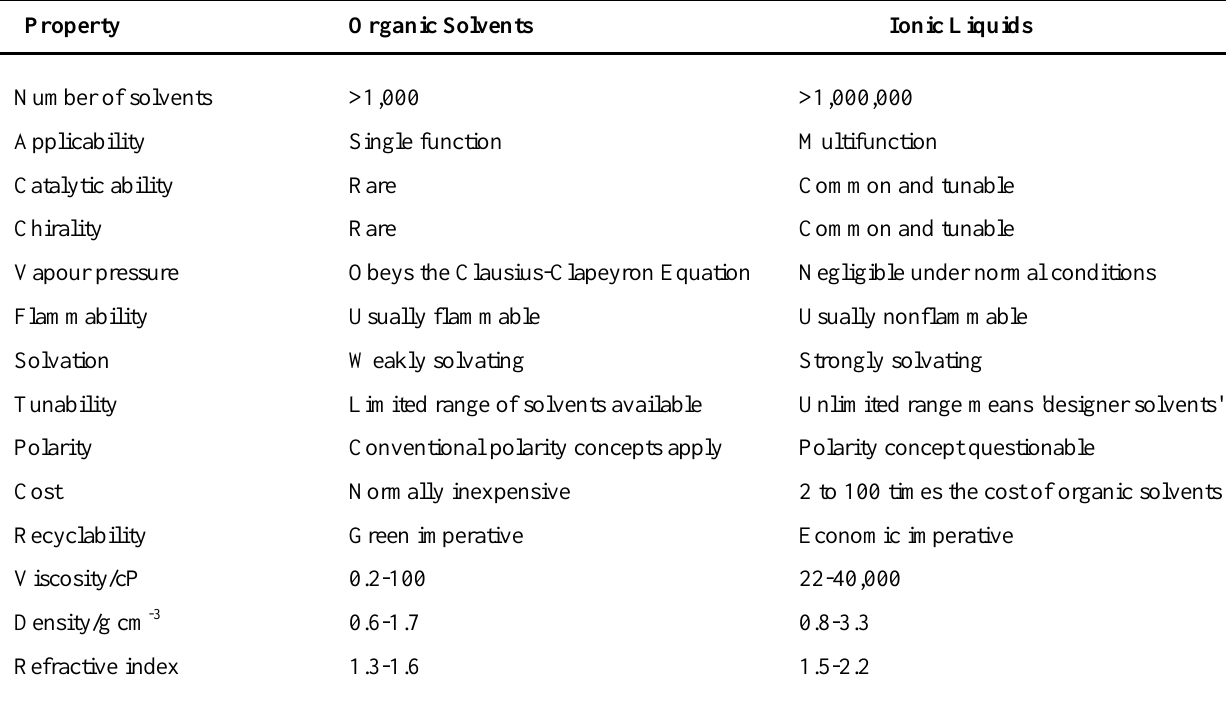
Table 1. Comparison of ionic liquids with organic solvents